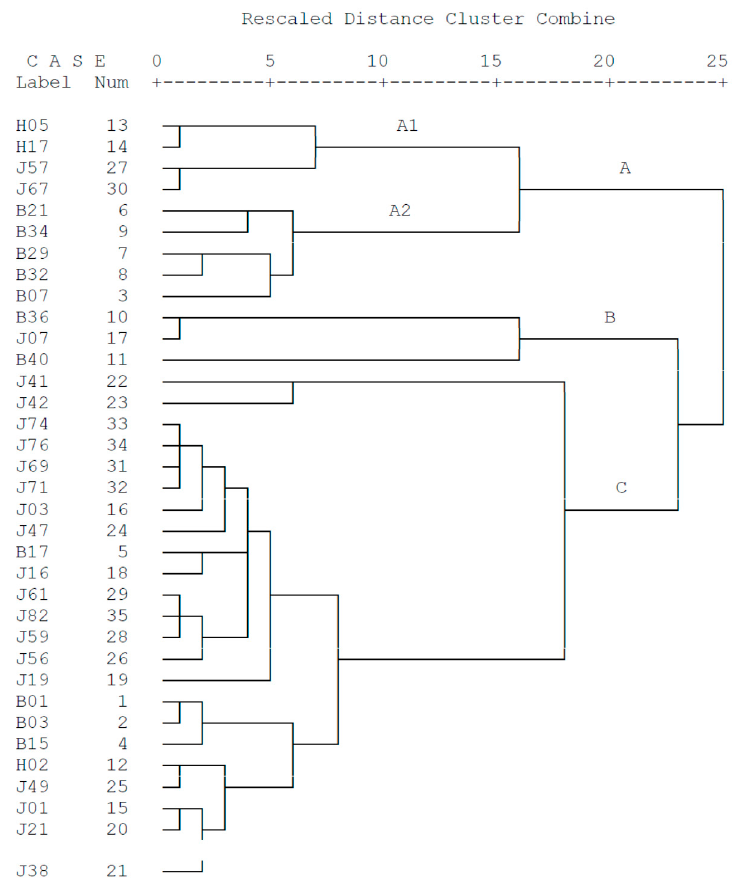
Figure 3. Cluster tree of the sampling stations in the eastern Beibu Gulf.